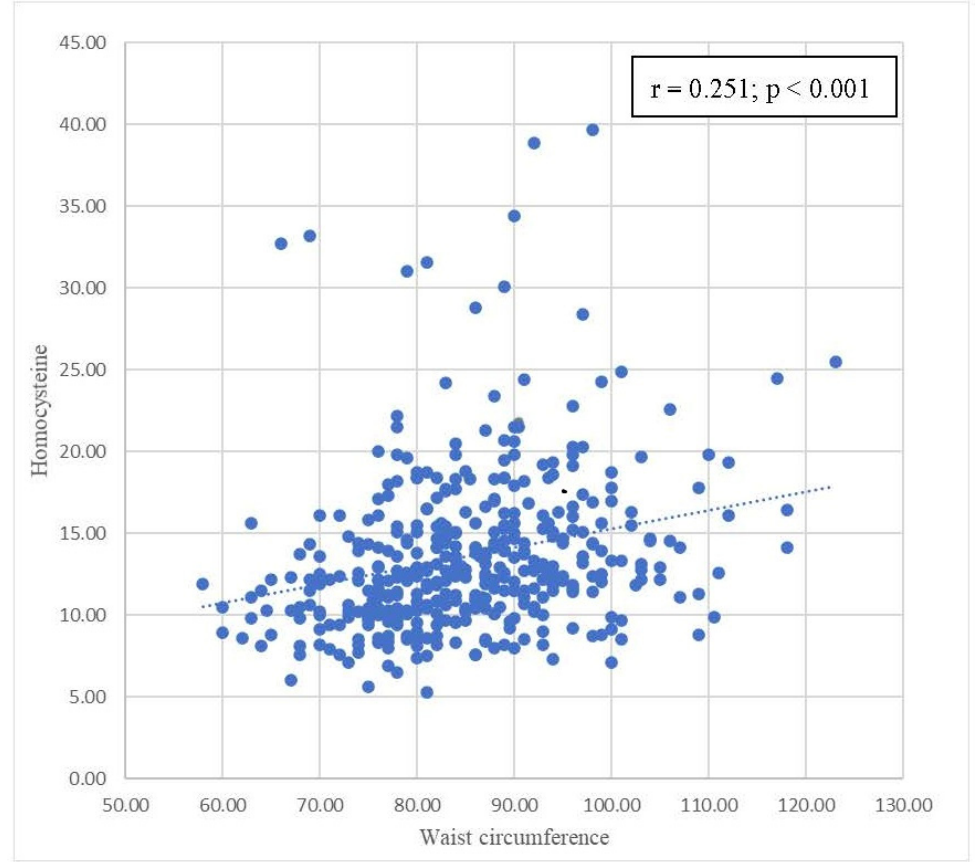
Figure 2. Scatterplot with the fit line of homocysteine levels by waist circumference.